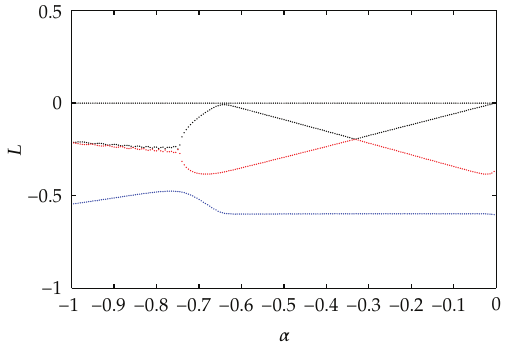
Figure 6: Lyapunov exponent with α ∈ (cid:5) − 1 , 0 (cid:6) , β (cid:7) 0 .